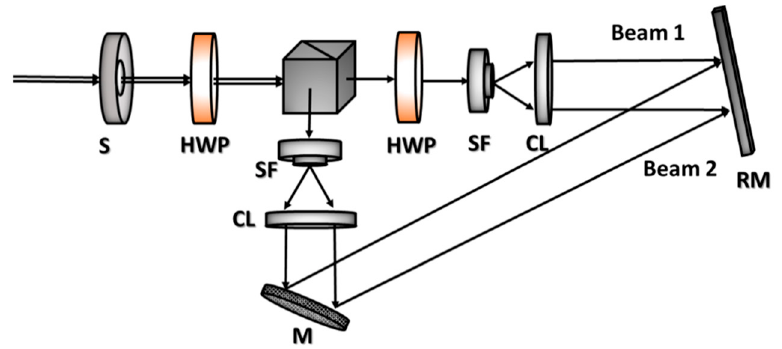
Figure 6. Experimental set up for recording transmission gratings (S—shutter; HWP—half wave plate; PBS—polarizing beam splitter; SF—spatial filter; CL—collimator; M—mirror; RM—recording material.